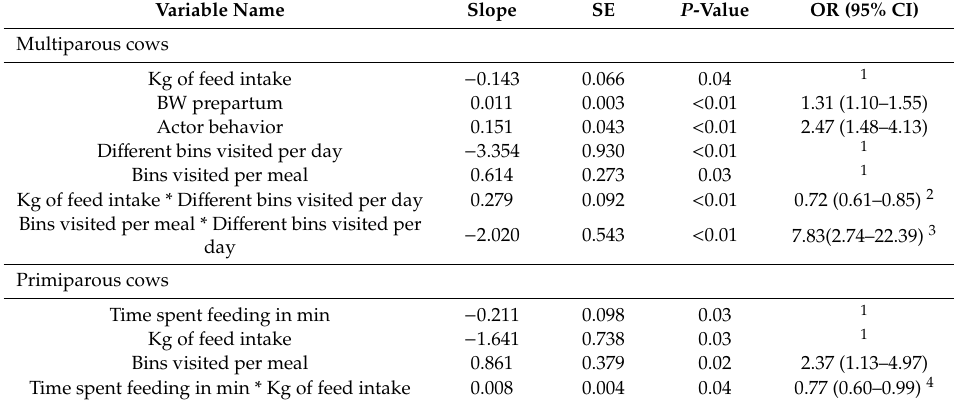
Table 2. Results from the multivariable models, separately for multiparous and primiparous cows. Estimates of slope, SE, p -value, odds ratio (OR), and 95% confidence interval (CI) are reported. Odds ratios for kg DMI, BW, actor behavior, bins visited / day, bins visited / meal, and time spent feeding are calculated based on units of 1 kg DMI, 25 kg BW, 6 actor behaviors, 1 bin visited / day, 1 bin visited / meal, and 15 min time spent feeding,